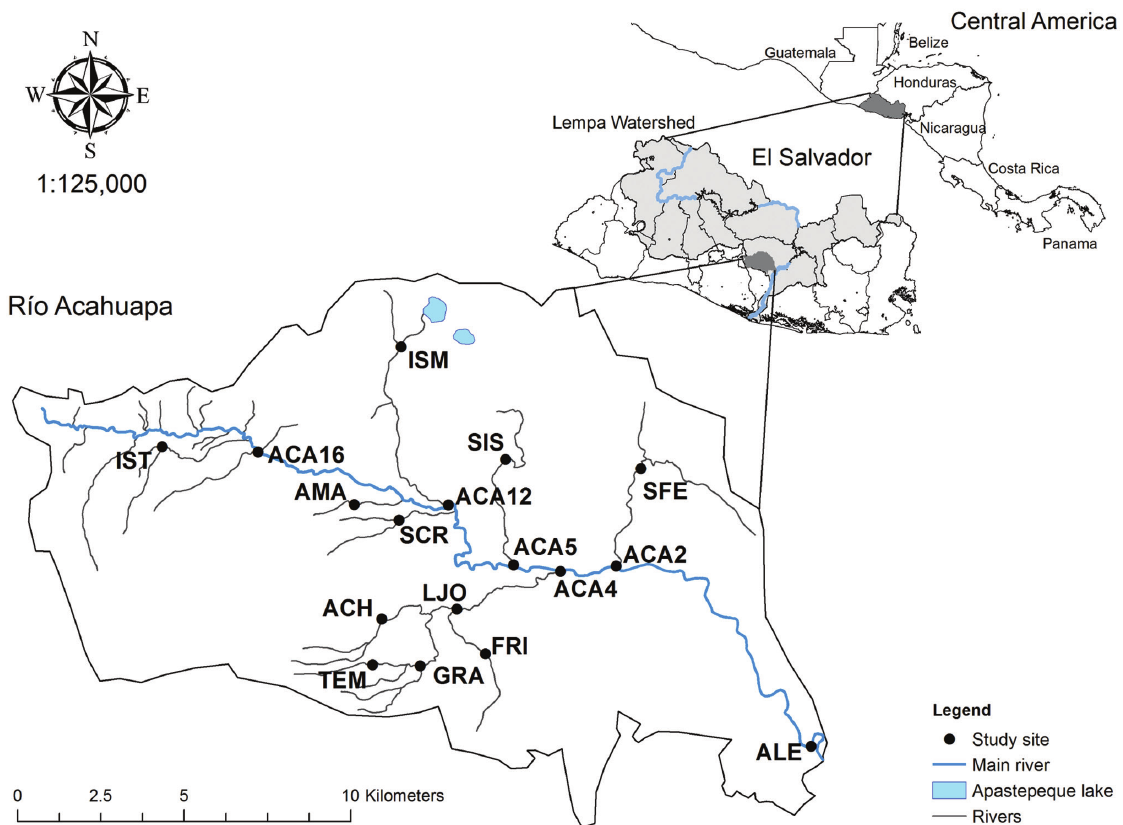
Fig. 1. Sampling sites in the basin of the Río Acahuapa, San Vicente, El Salvador, 2011-2012. Acahuapa-Lempa (ALE), Acahuapa (ACA2), San Felipe (SFE), Acahuapa (ACA4), Acahuapa (ACA5), La Joya (LJO), Frío (FRI), Grande (GRA), Tempates (TEM), Achichilco (ACH), Sisimico (SIS), Acahuapa (ACA12), San Cristóbal (SCR), Amapupulta (AMA), Ismataco (ISM), Acahuapa (ACA16), Istepeque